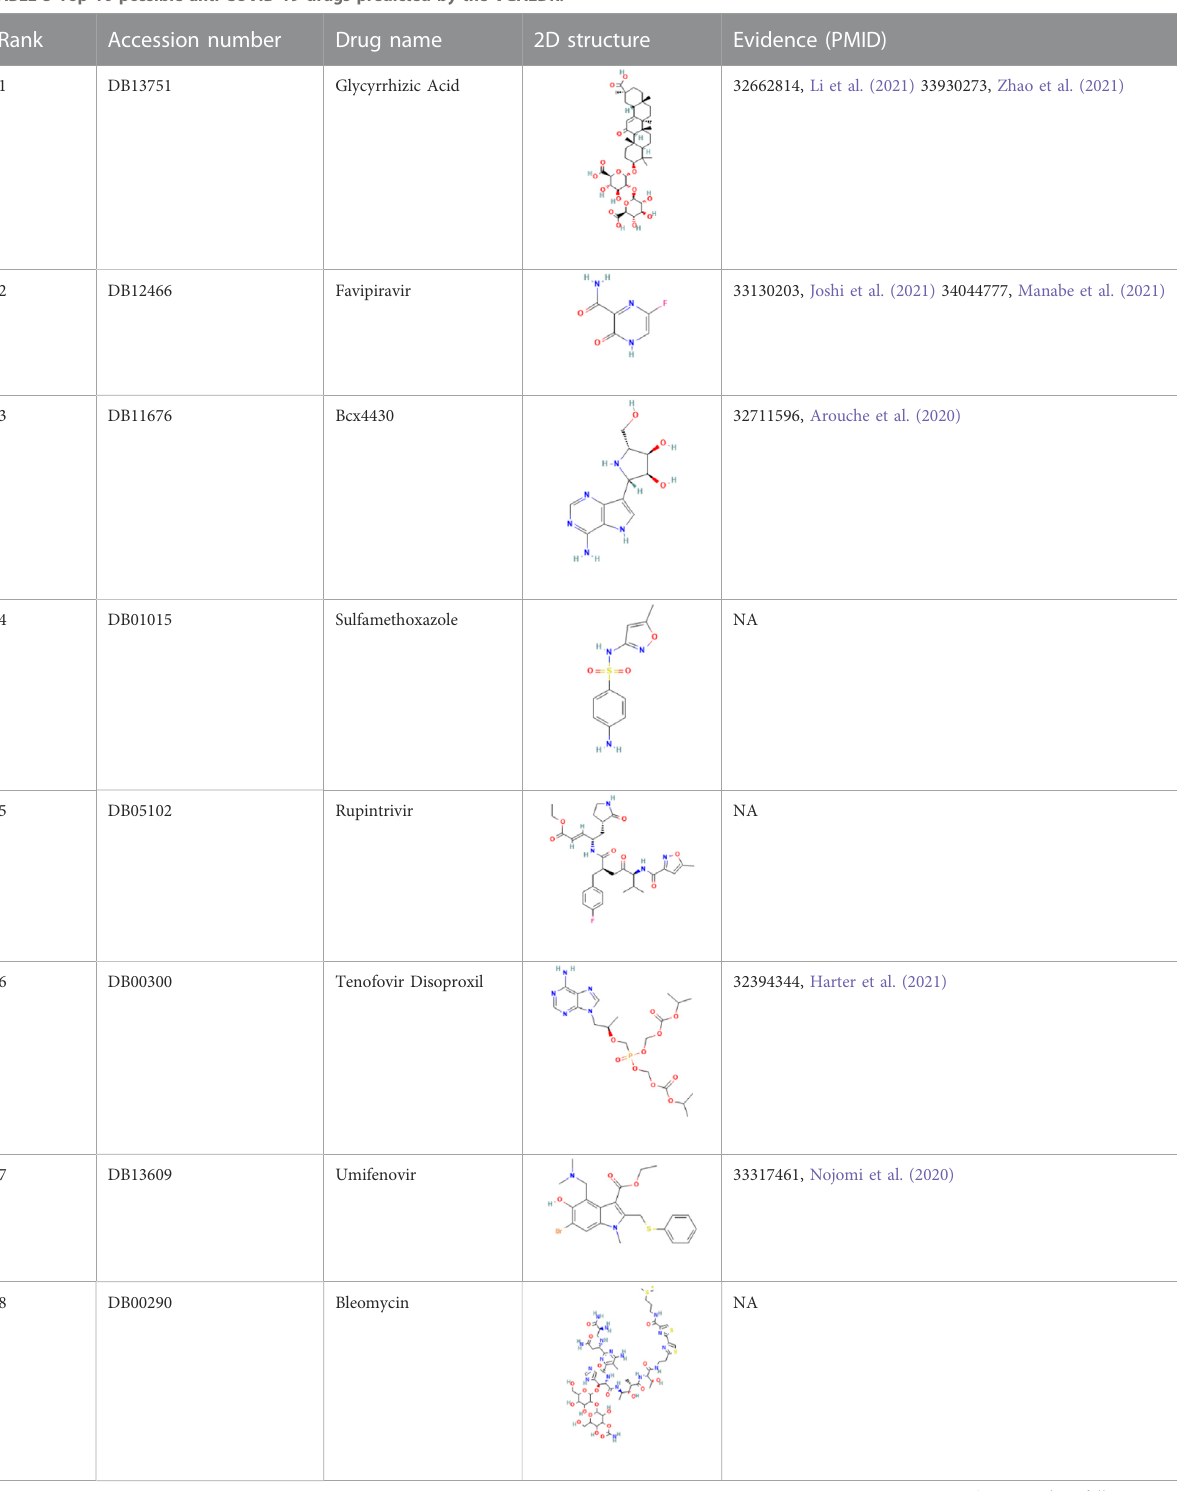
TABLE 5 Top 10 possible anti-COVID-19 drugs predicted by the